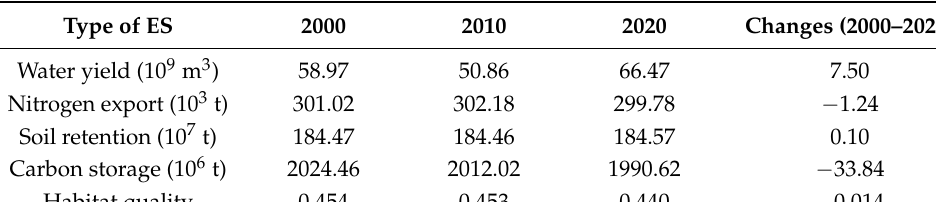
Table 4. Changes in ESs in Anhui Province from 2000 to 2020.